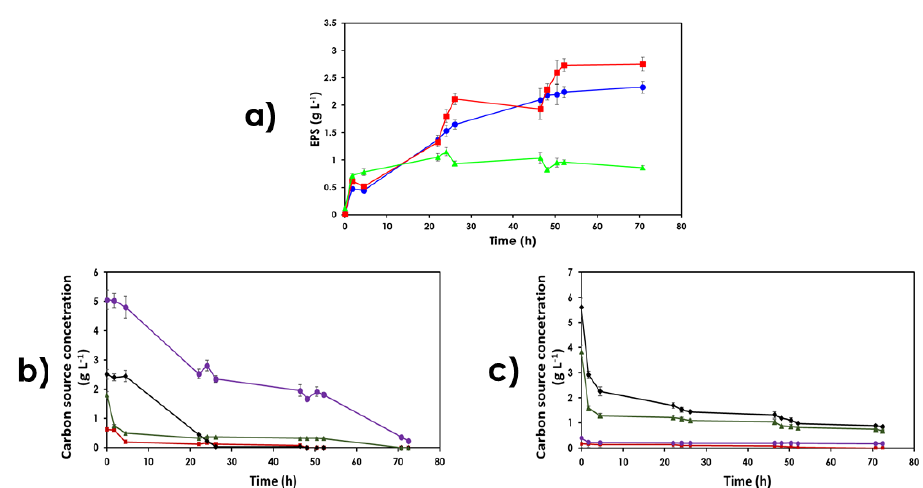
Figure 3. ( a ) EPS production by cultivating the BU-4 strain in a glucose-based medium ( • ), and in pretreatment liquids of quinoa stalks ( (cid:4) ), and Curupa ú sawdust ( (cid:78) ); ( b ) Carbon source consumption for quinoa stalks pretreatment liquid: xylose ( • ), glucose ( (cid:7) ), arabinose ( (cid:78) ), and cellobiose ( (cid:4) ); ( c ) Carbon source consumption for Curupa ú hydrolysates: glucose ( (cid:7) ), arabinose ( (cid:78) ), xylose ( • ), and cellobiose ( (cid:4) ).